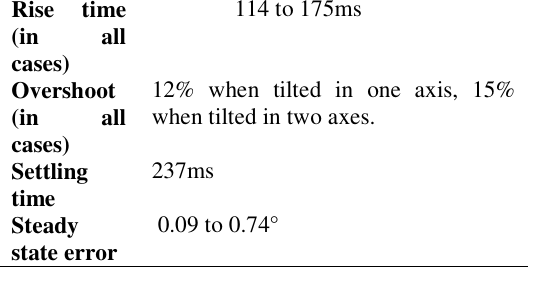
The key values of simulation results .